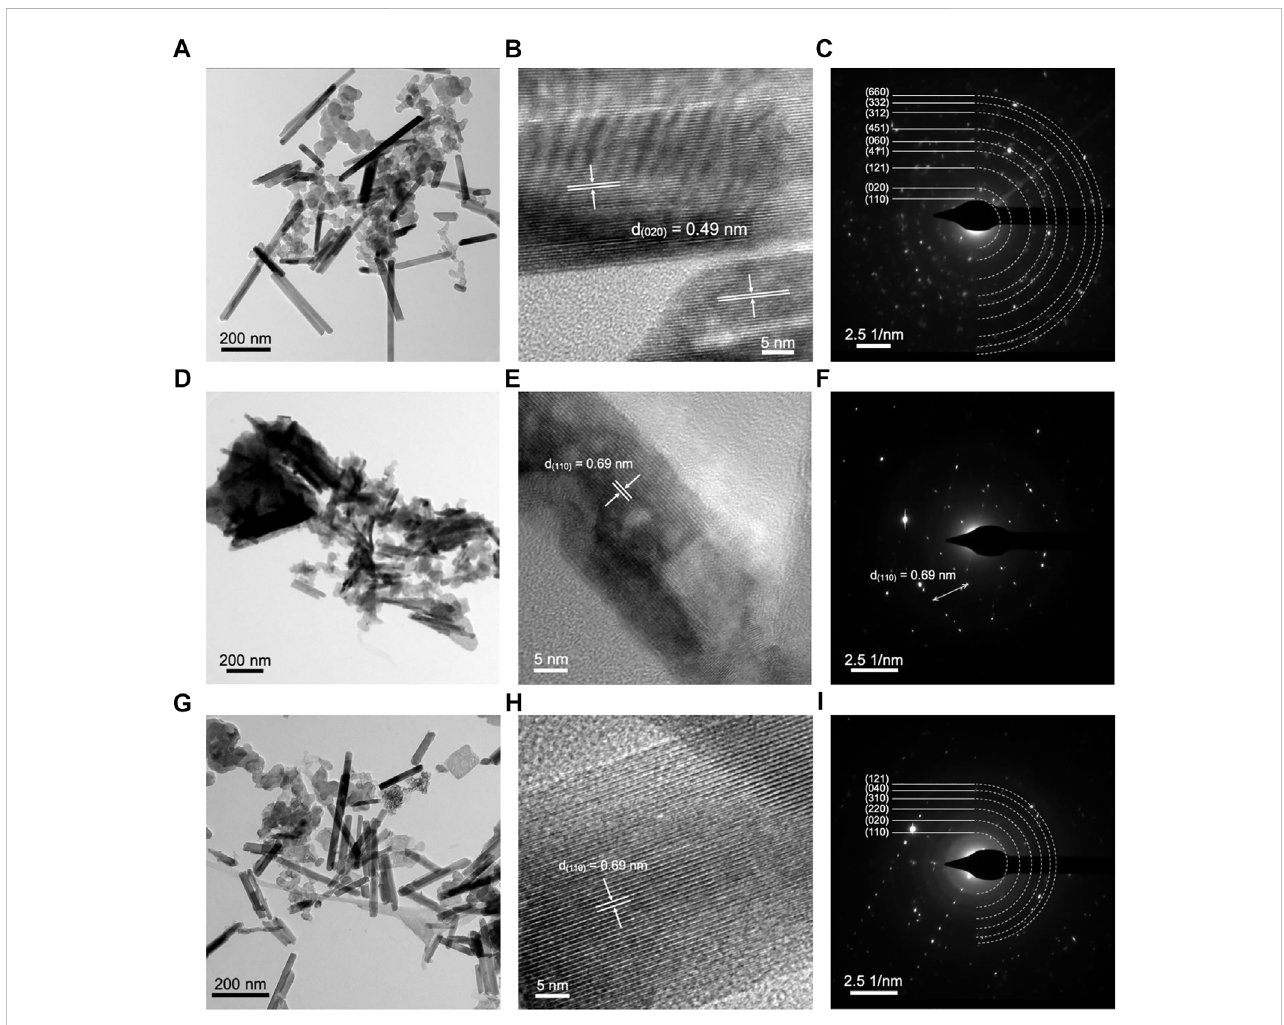
FIGURE 6 TEM, HRTEM, and SAED pattern images of Ce-MnO2 cathode (A – C) before cycling, (D – F) after discharge, and (G – I) after charge.